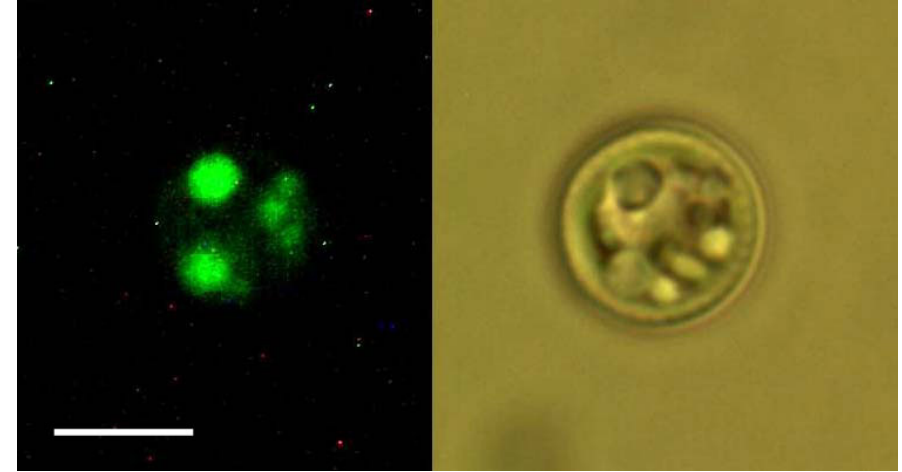
Figure 1. Visualization of the lipid bodies in algal cells. Nile Red (NR) fluorescence image of the lipid bodies (left) and Differential Interference Contrast (DIC) image (right) of the same living cell are compared. Complex internal compartmentalization is visible in the DIC image and the structures corresponding to the lipid bodies can be clearly identified. The scale bar is 5